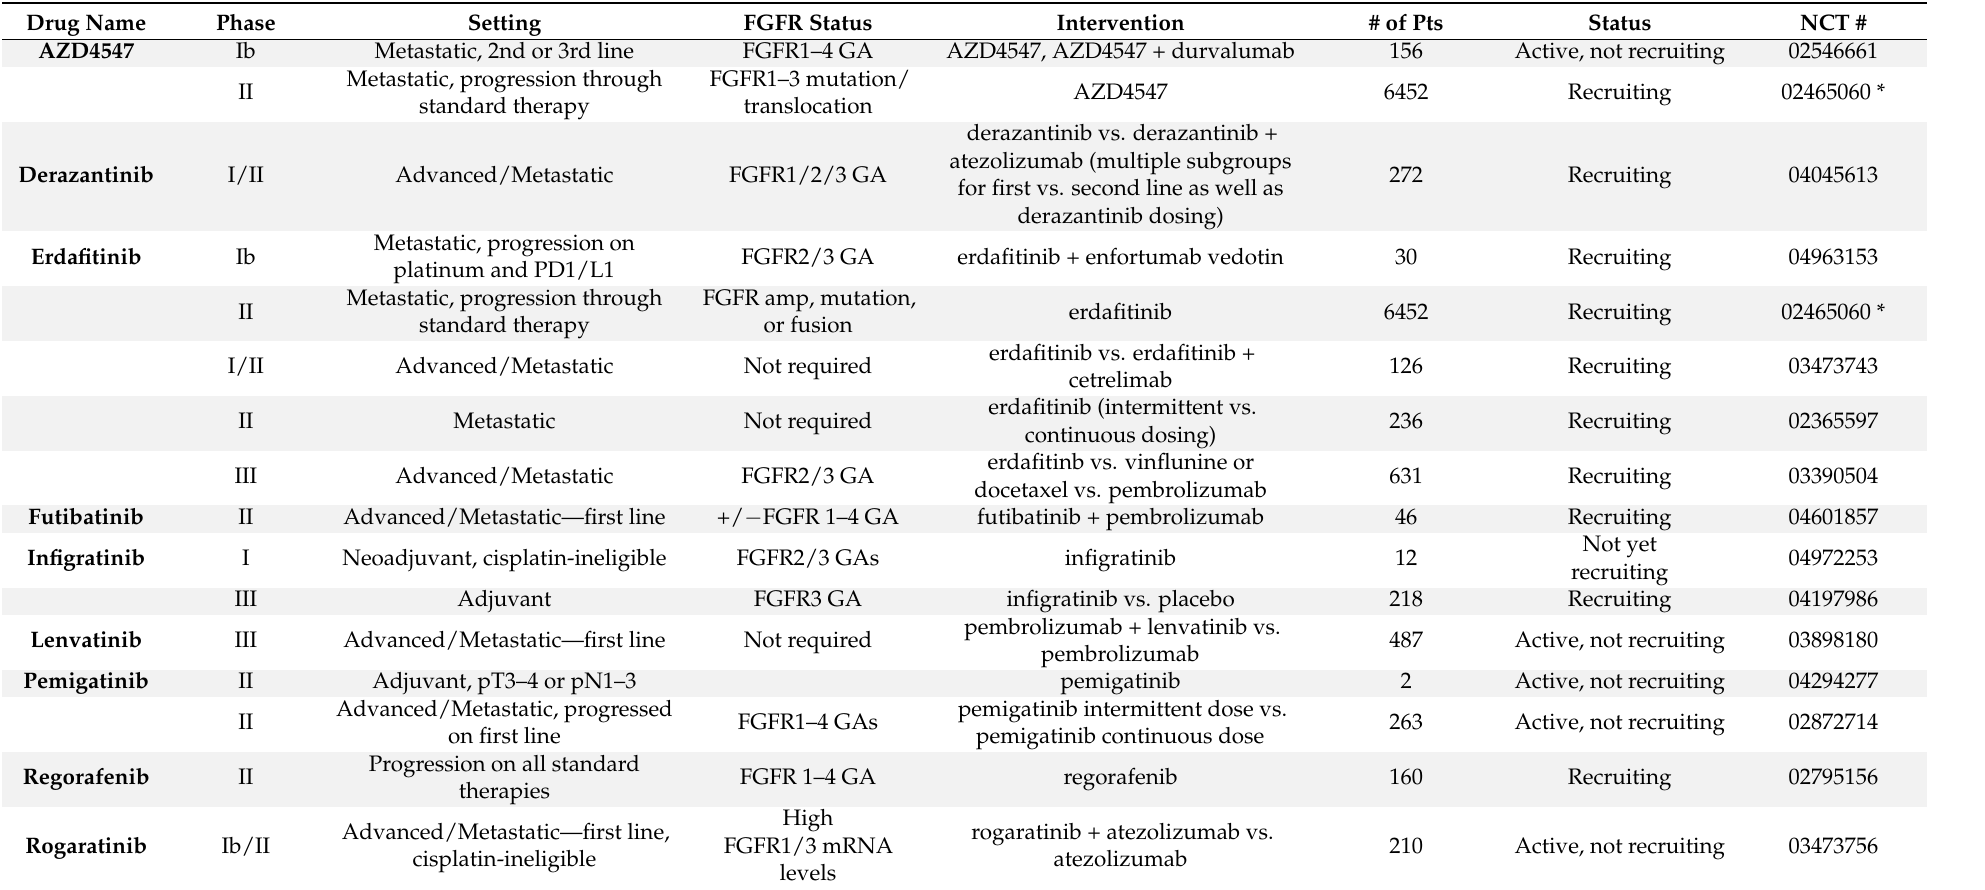
Table 1. Ongoing Clinical Trials of FGFR Inhibitors in advanced or metastatic bladder